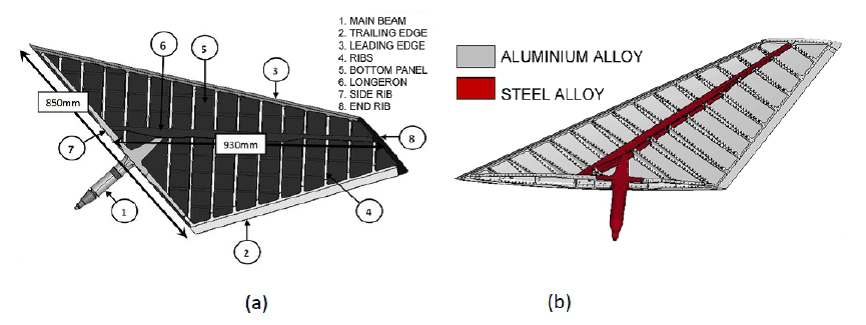
Figure 1: (a) Structural Members of the control surface and (b) Material Based Model Coloring